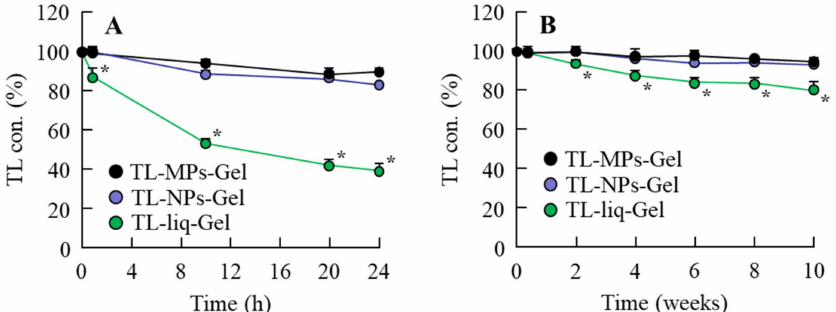
Figure 2. XRD pattern and solubility of TL in TL formulations. ( A ) and ( B ) XRD pattern of solid TL in TL-MPs-Gel ( A ) and TL-NPs-Gel ( B ) by the Mini Flex II. ( C ) solubilities of TL in TL-MPs-Gel and TL-NPs-Gel. N = 6. * P < 0.05, vs. TL-MPs-Gel. The XRD patterns of the crystalline materials show sharp peaks, and no di ff erences with or without bead mill treatment. The ratio of dissolved TL in TL-NPs-Gel was 5.3-fold higher than that in TL-MPs-Gel.